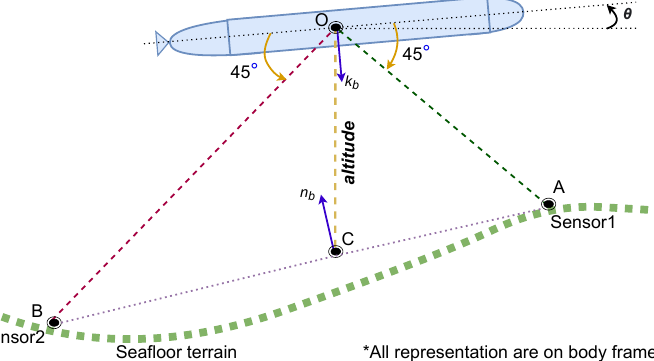
Figure 7. X300: Allocation of altitude sensors w.r.t. center of vehicle body frame and estimation of vehicle altitude as length of the vertical segment. The slanting rays emerging from the vehicle highlight the position of the altitude sensors w.r.t. the body of the